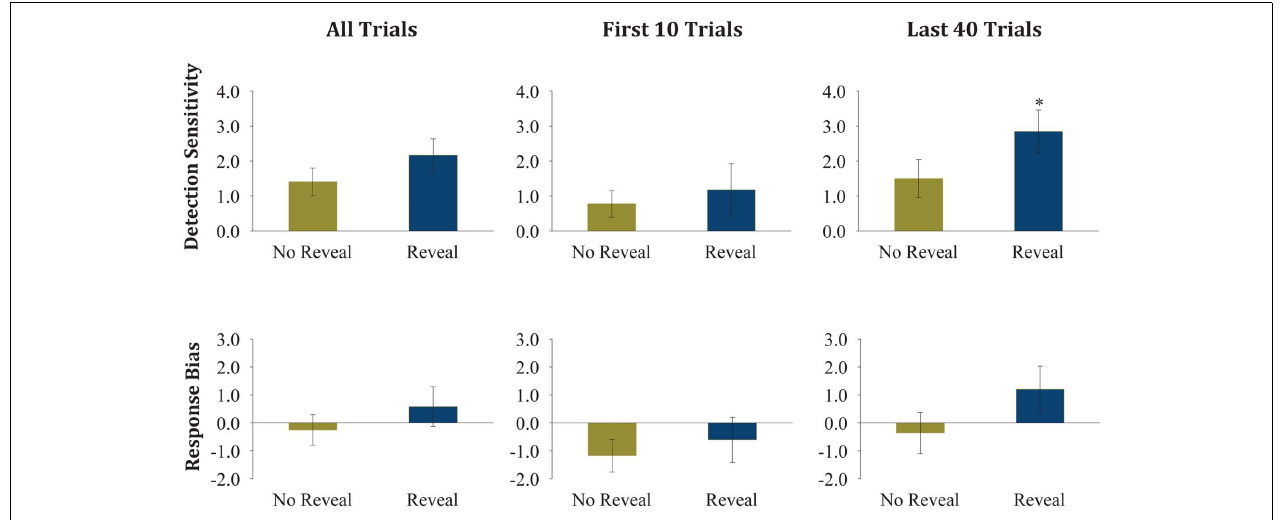
and response bias for the first 10 trials only. Right Column: Detection sensitivity and response bias for the last 40 trials. Error bars indicate SEM across subjects. *Paired t -test, p <